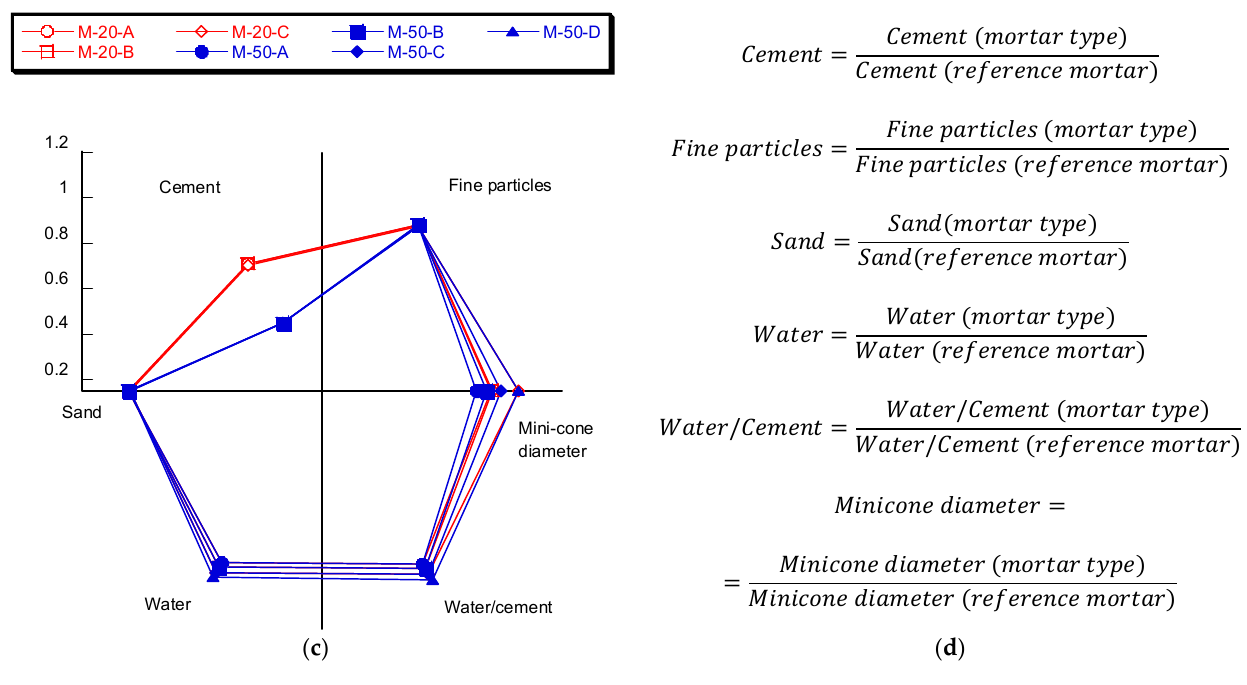
Figure 15. Influence of the mix proportions on the workability, ( a ) corresponding to 20% replacement, ( b ) 50% replacement, ( c ) all cases sorted by replacement percentage, ( d ) equations used to obtain each variable represented.